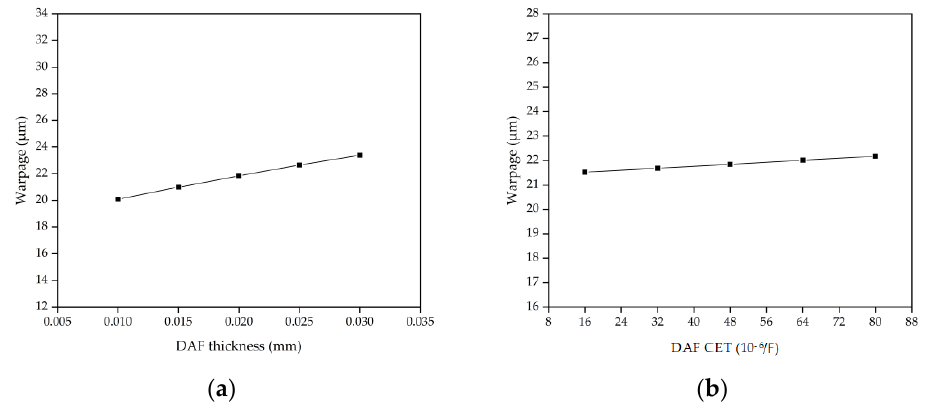
Figure 15. Influence of DAF on warpage. ( a ) Influence of DAF thickness on warpage; ( b ) influence of DAF CET on warpage.